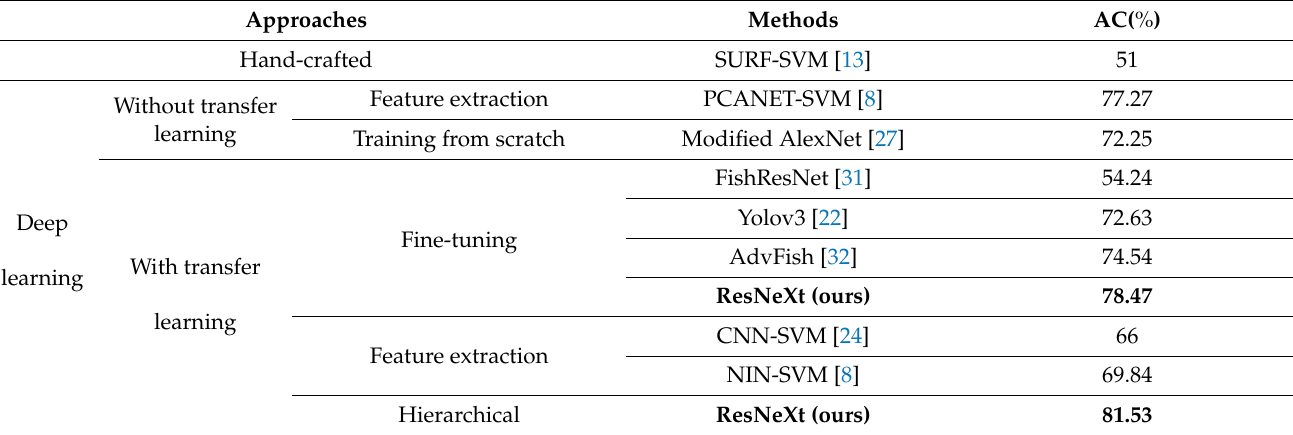
Table 7. Comparison of fish recognition accuracies of various methods on the LCF-15